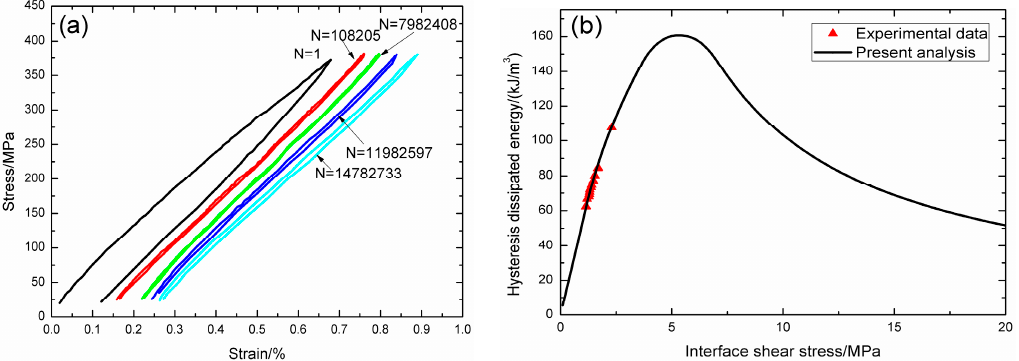
Figure 8. ( a ) The experimental fatigue hysteresis loops corresponding to different cycle number; and ( b ) the experimental and theoretical fatigue hysteresis dissipated energy versus interface shear stress curve of 2D woven C/SiC composite under σ max = 375 MPa at room temperature.